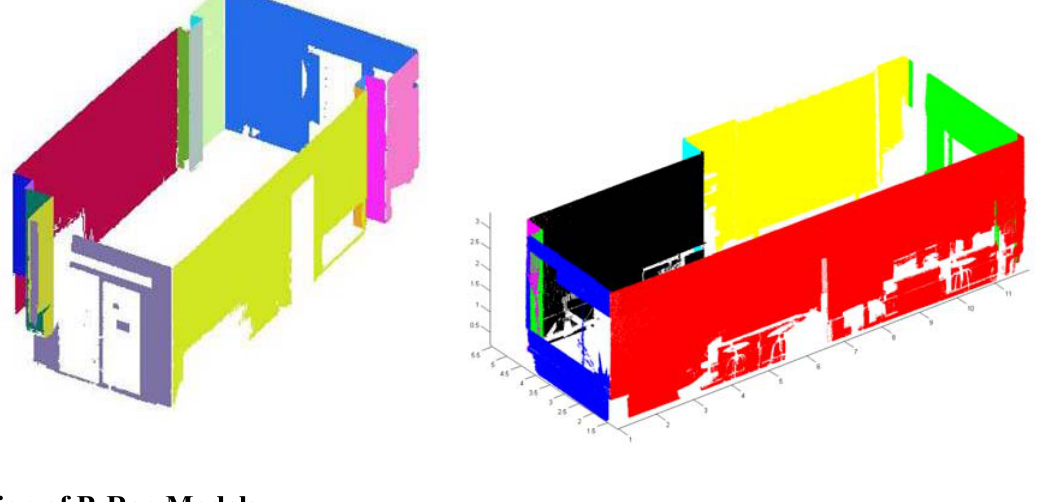
Figure 4. Retrieval of 3D points corresponding to the